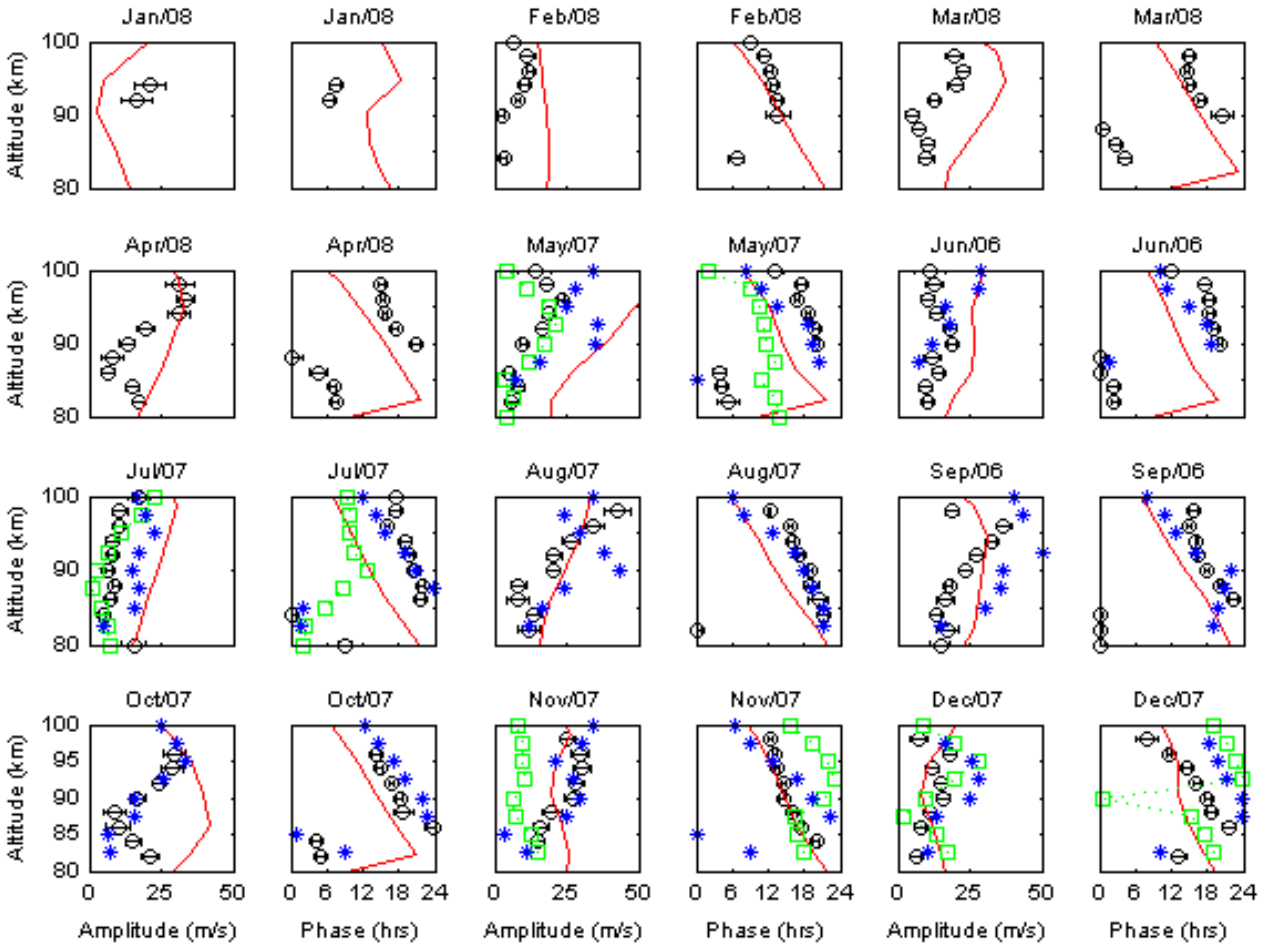
Fig. 2. Height profile of amplitude and phase (in UT) of zonal diurnal tides for 12 months. Red curves represent the GSWM02 model values taken from the website. Blue stars represent monthly TIDI values (Wu et al., 2008). Green squares represent daily TIDI values reconstructed from different modes (Oberheide and Forbes, 2008). Black circles with error bars represent JASMET